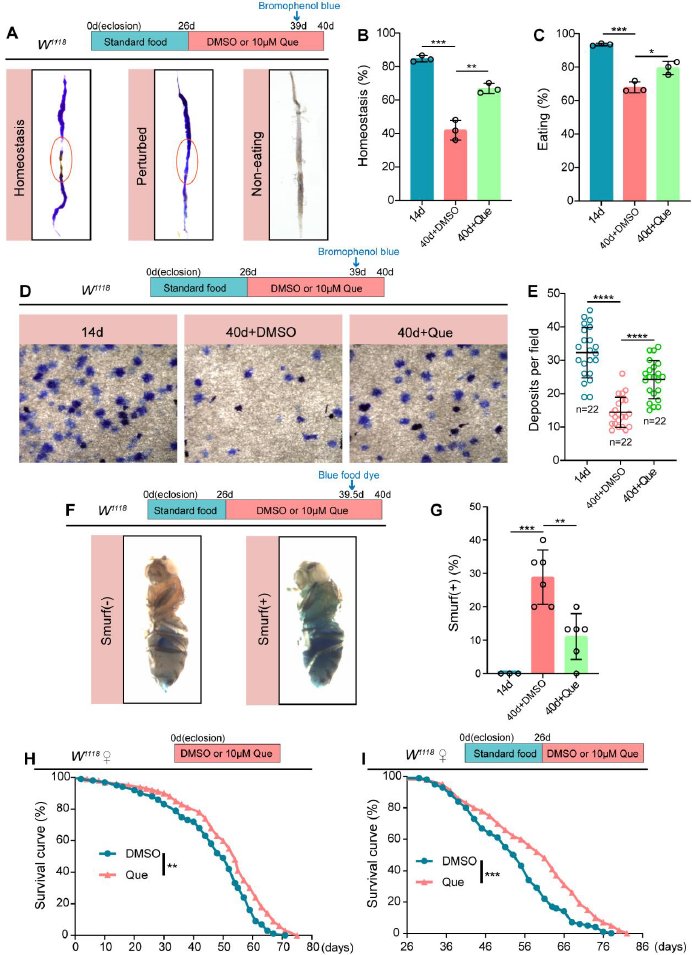
Figure 3. Que prevents age-related gut dysfunction and prolongs the lifespan. ( A ) Representative images of the intestinal acid-base homeostasis and the non-eating intestine of 14- and 40-day-old flies without Que supplementation and 40-day-old flies with 10 µM Que supplementation. A pink ellipse indicates the CCR. “Homeostasis” refers to CCR as yellow and “Perturbed” refers to CCR as blue. “Non - eating” means the flies did not eat, and the guts are not stained with bromophenol blue. ( B , C ) The percentage of acid-base balanced intestines ( B ) and eating intestines ( C ) in experiment ( A ). N ≥ 50 flies per group. Three independent experiments were conducted. ( D , E ) Representative images ( D ) and quantification ( E ) of excretion deposits of 14-and 40-day-old flies without Que supplementation and 40-day-old flies with 10 µ M Que supplementation. Each group included 30 flies and three independent experiments were conducted. n: number of field counted. ( F , G ) Representative images ( F ) and quantification ( G ) of the percentage of the smurf flies in 14- and 40-day-old flies without Que supplementation and 40-day-old flies with 10 µ M Que supplementation. Smurf (+) refers to a fly that leaks the blue dye from the gut into other tissues. Each group included 15 flies and three independent experiments were conducted. ( H , I ) Survival percentage of female W 1118 flies with DMSO (blue curve) or Que (pink curve) supplementation starting from eclosion (0-day-old) or middle age (26-day-old). Each group included 100 flies. Three independent experiments were conducted. Error bars represent SDs. Log-rank test was used for lifespan analysis. Student’s t -tests, * p < 0.05, ** p < 0.01, *** p < 0.001, and **** p <